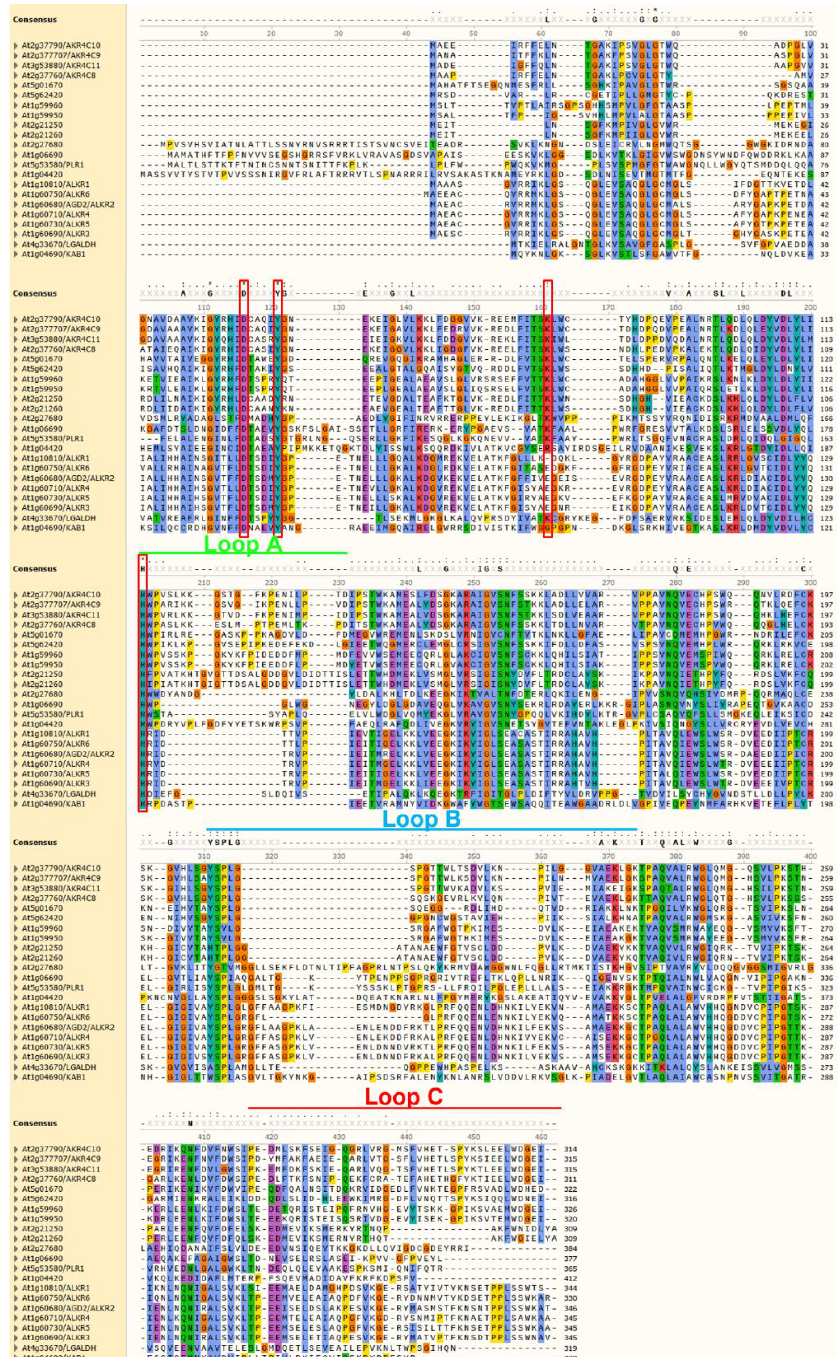
Figure 6. Multiple sequence alignment of AKRs from Arabidopsis . Red boxes highlight the catalytic tetrad residues, while green, cyan and red bars above the alignment denote the flexible loops defining the active site important for substrate specificity. Elements were assigned using the structural information of Arabidopsis AKR4C8 (PDB code 3h7r). Residues are color-coded based on their properties: red: positive; blue: hydrophobic; green: polar; orange: glycine; purple: negative; teal: aromatic; yellow: